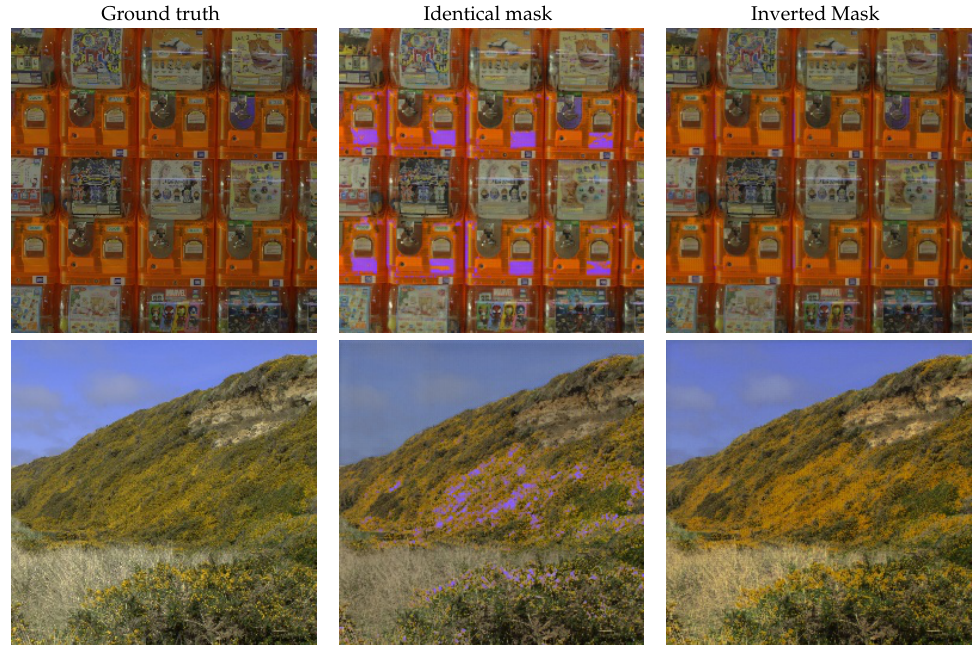
Figure 9. Result images when identical mask and inverted mask are applied to the network. Identical mask has 3 channels of M f for H , S , and V . Inverted mask has one channel of 1 − M f for H channel and two channels of M f for S and V channel. Artifacts can be seen in the result images of identical